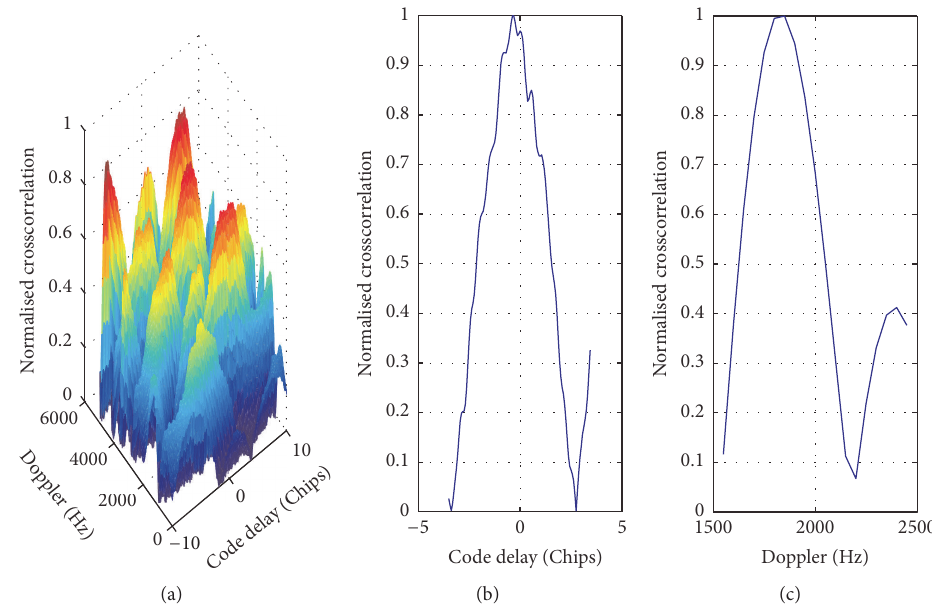
Figure 13: Correlation peaks after interference suppression by S-MPDR beamformer for scenario